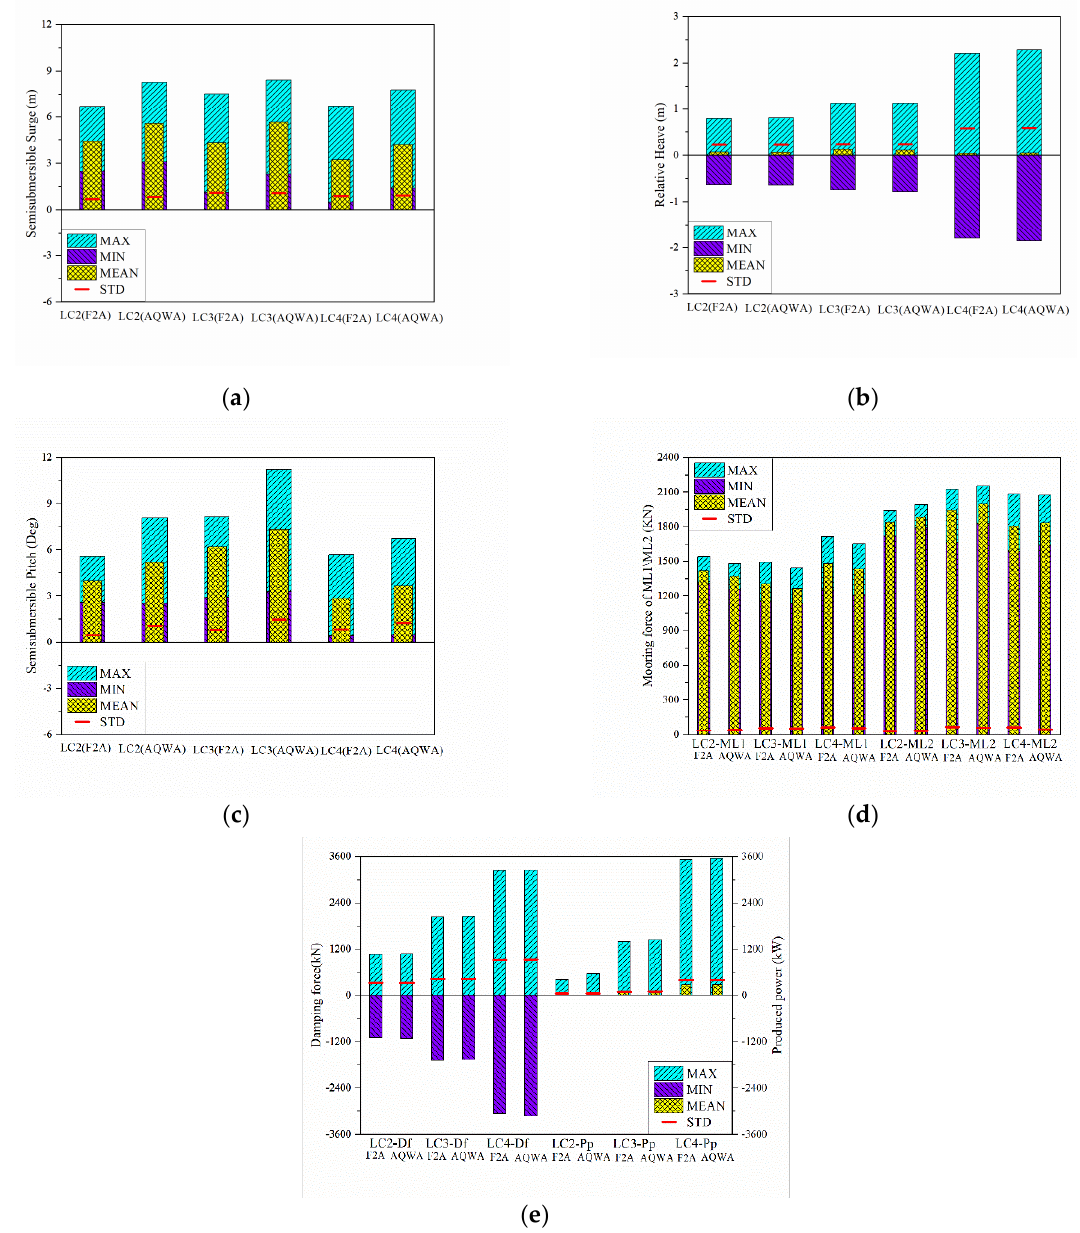
Figure 12. Comparison of the statistical results of in LC2, LC3, LC4: ( a ) Surge Motion; ( b ) Relative Heave Motion; ( c ) Pitch Motion; ( d ) Mooring Force of ML1 and ML2; ( e ) Damping Force (Df) and Produced Power (Pp).